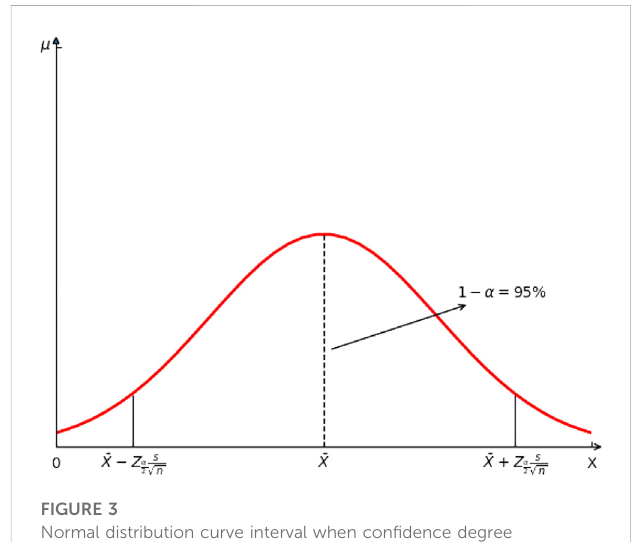
FIGURE 3 Normal distribution curve interval when con fi dence degree 1- α =